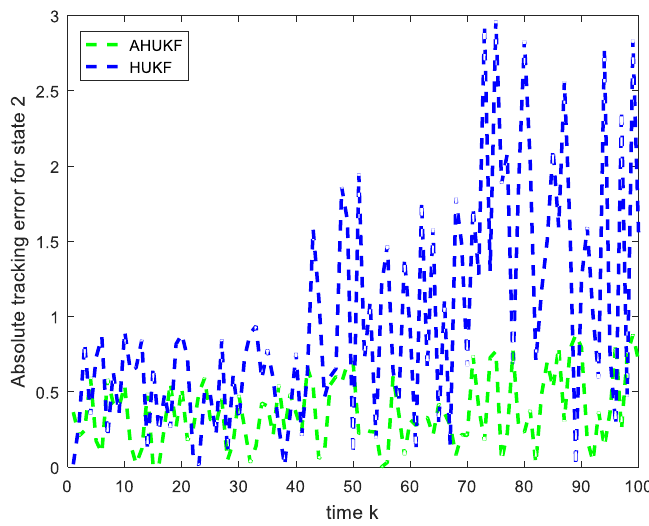
Figure 3. Tracking error curve for State 2.